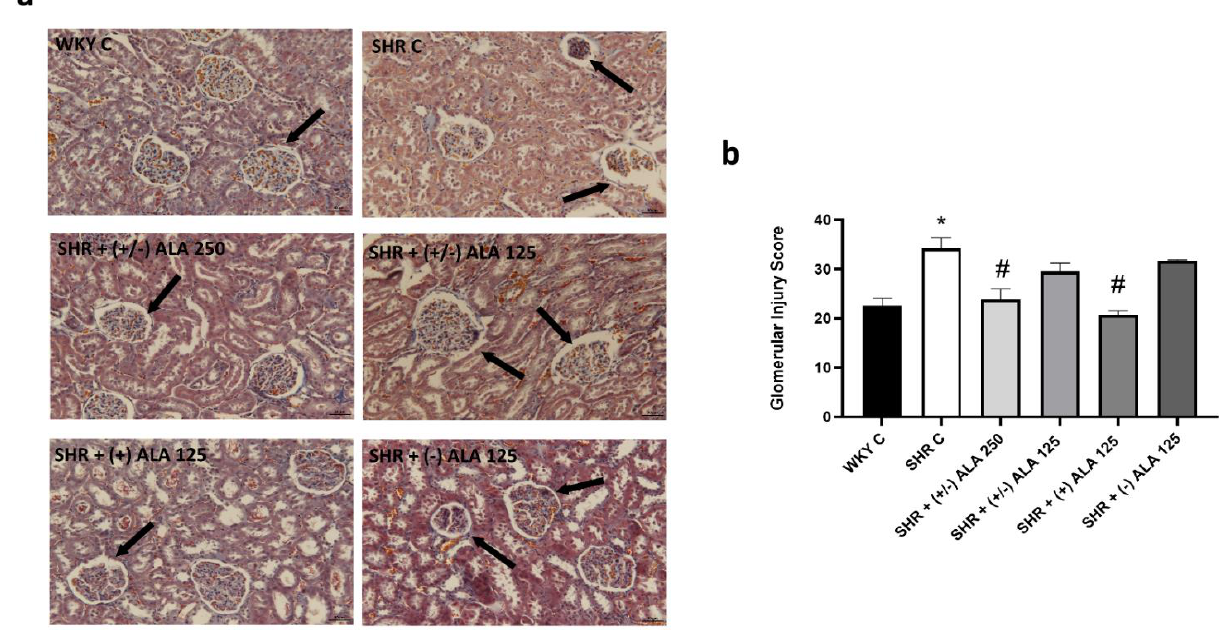
Figure 4. Renal glomerular morphology. ( a ) Renal tissue of WKY C, SHR C, SHR + (+/ − ) alpha lipoic acid (ALA) 250 µ mol/kg/day, SHR + (+/ − ) ALA 125 µ mol/kg/day, SHR + (+) ALA 125 µ mol/kg/day, SHR + ( − ) ALA 125 µ mol/kg/day were stained using Masson’s trichrome technique. Arrow: damaged glomerulus. Calibration bar: 50 µ m; ( b ) Morphometric analysis to assess the glomerular injury score. Data are mean ± S.E.M. * p < 0.05 vs. WKY C; # p < 0.05 vs. SHR C.